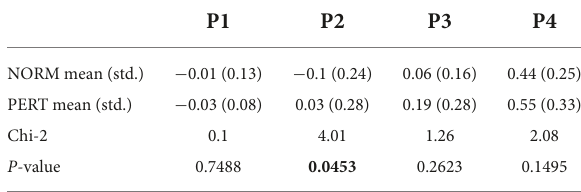
TABLE 3 Power values (in db/Hz) extracted from the power spectral density spectra at the four frequency bins that corresponded to musical metrical levels (P1 – P4), compared across experimental conditions for the motion of the head. HEAD P1 P2 P3 P4 NORM mean (std.) 0.173 (0.024) 0.096 (0.047) 0.033 (0.017) 0.007 (0.010) PERT mean (std.)